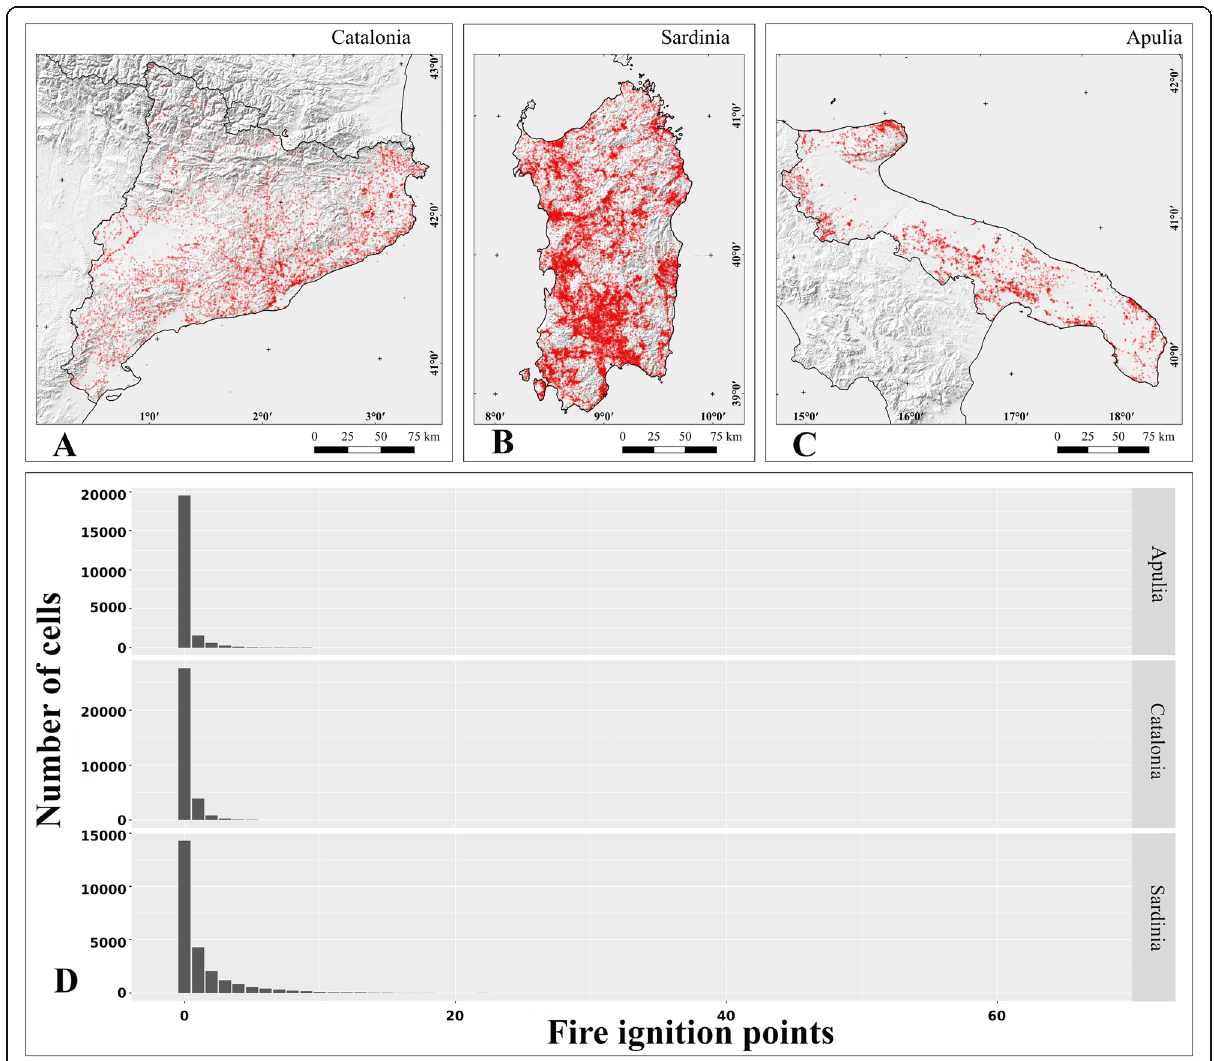
Fig. 3 Spatial distribution of fire ignition points (red dots) across Catalonia ( a ), Sardinia ( b ), and Apulia ( c ). Fire ignition point frequency for the three study regions ( d